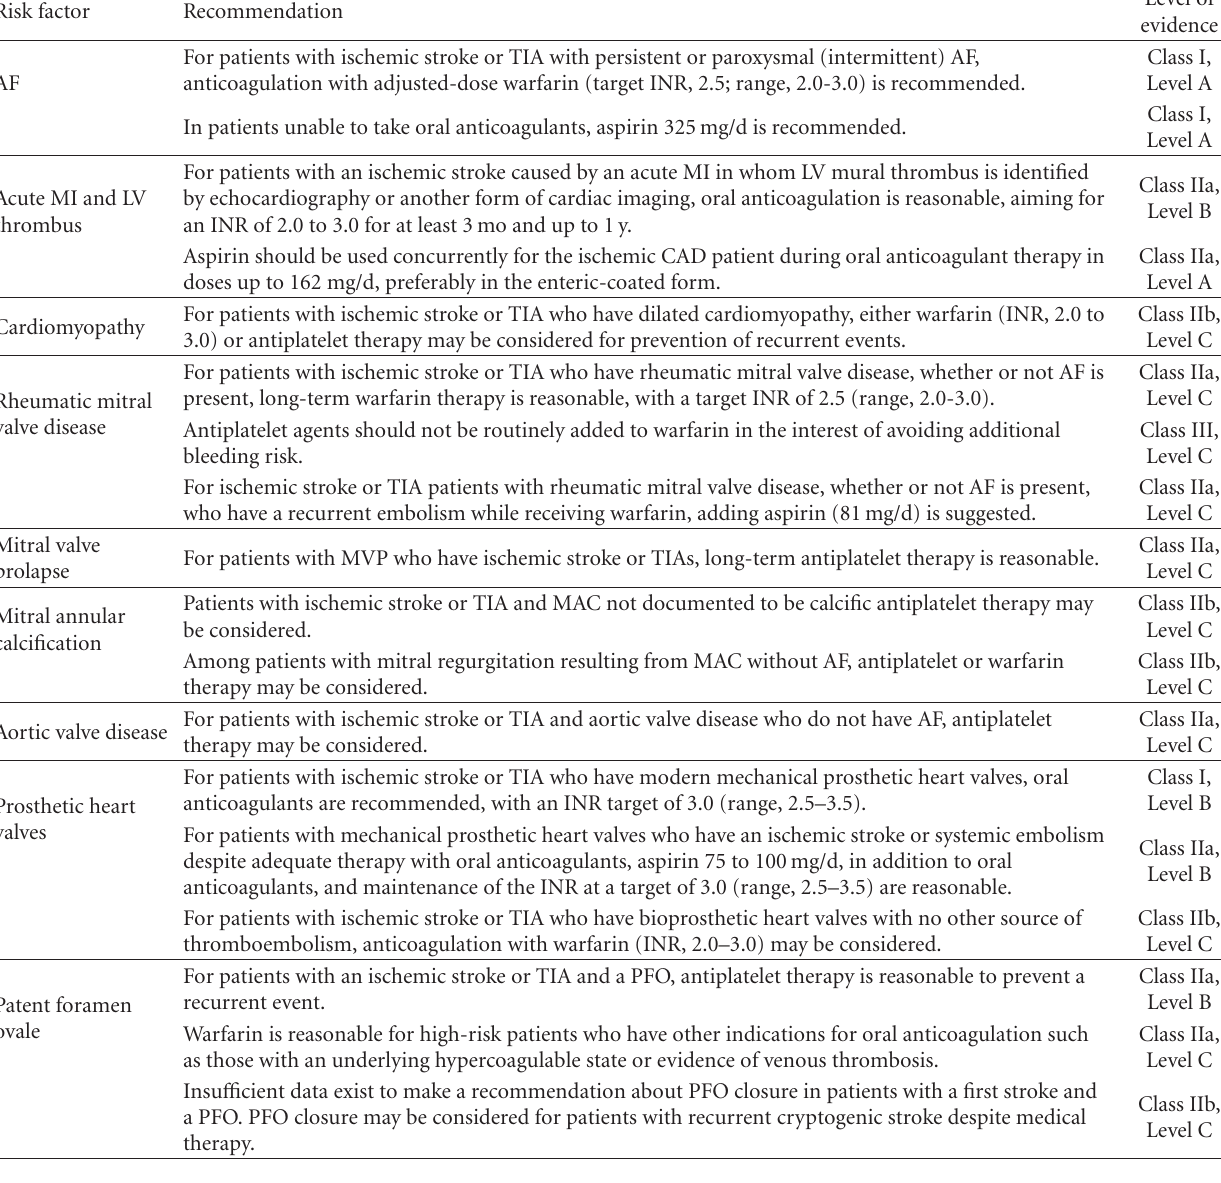
Table 1: Recommendations for patients with cardioembolic stroke types (AHA Guideline